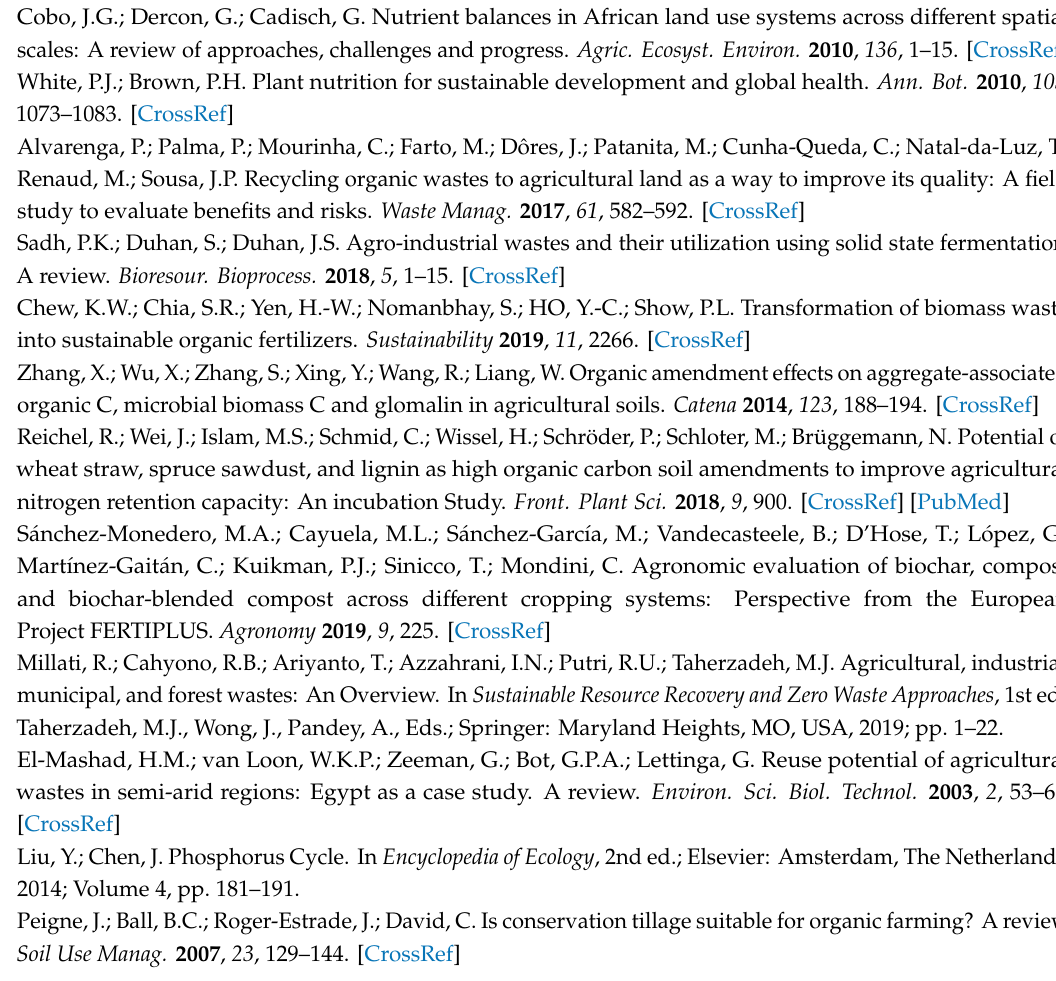
Figure S1: Layout of four replications of an experimental design that includes 9 integrated nutrient management (INM) treatments and two biofertilizers treatments (with ( + ) and without ( − ) seed inoculation), showing locations of INM and biofertilizers treatments. The all treatments were applied in the same place in two seasons (winter for faba bean and summer for maize) and in two